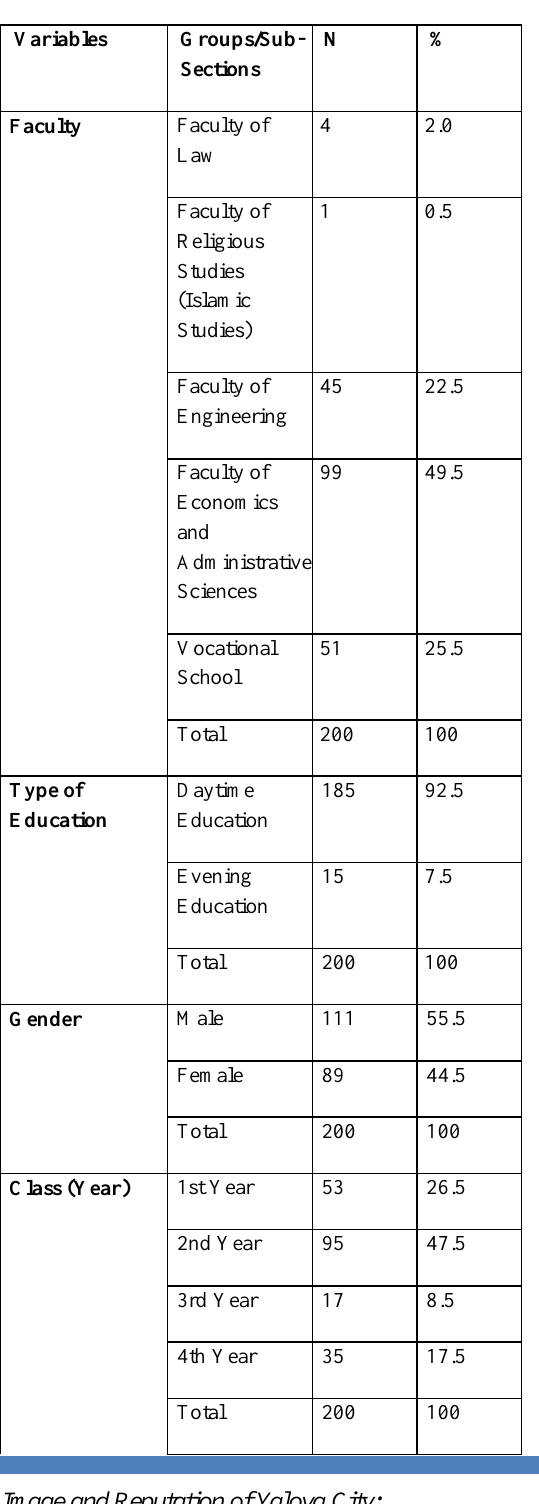
Table 2. Demographic Characteristics and Data of